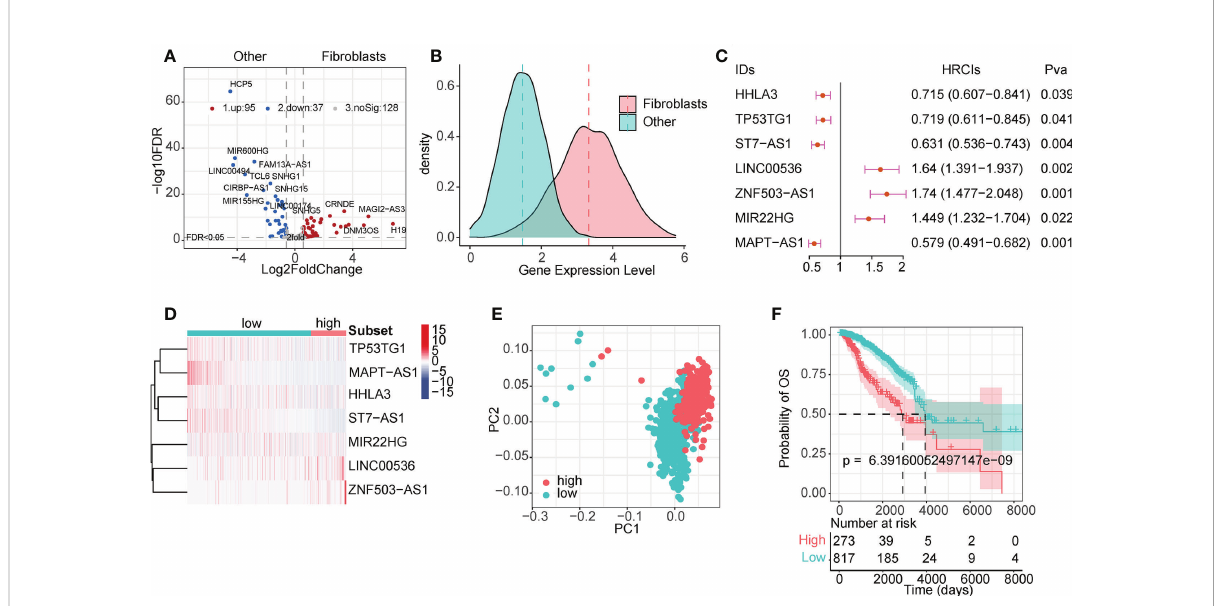
FIGURE 2 CAF-speci fi c lncRNAs identi fi cation and model construction. (A) Differentially expressed lncRNAs between CAF and other TME cells. (B) The density plot of expression values of CAF-speci fi c lncRNAs and other lncRNAs. (C) Forest plot of the seven lncRNAs used for model construction. (D) Heatmap of the expression level of eight lncRNAs used for model construction. (E) PCA analysis of the high- and low-risk subgroups. (F) Kaplan – Meier survival curves for patients in TCGA database assigned to high- and low-risk groups based on the risk score.